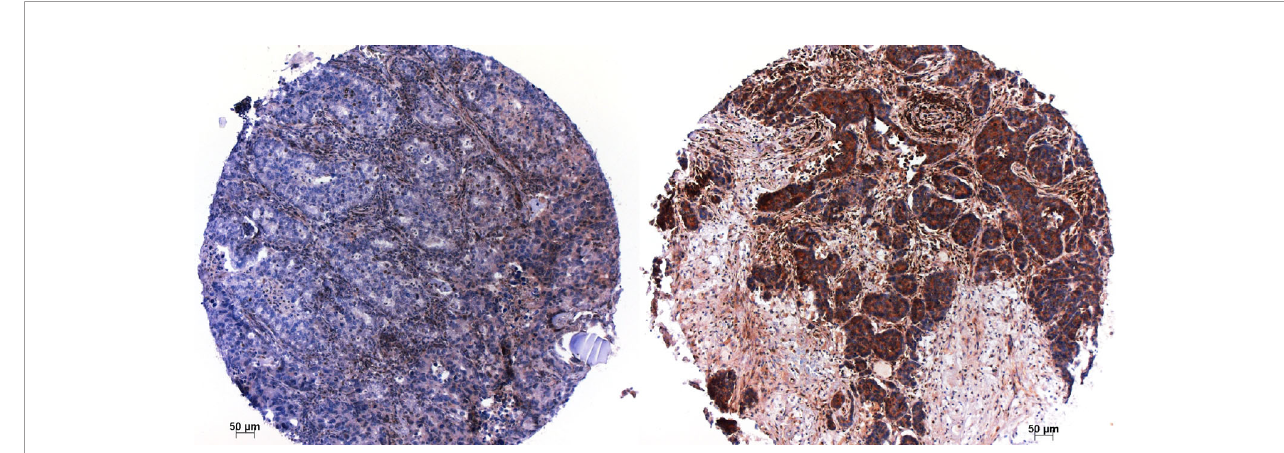
FIGURE 2 | Immunohistochemistry for RB1; a case, which lost RB1 on the left, and another case, which retained RB1 to the right. Magni fi cation